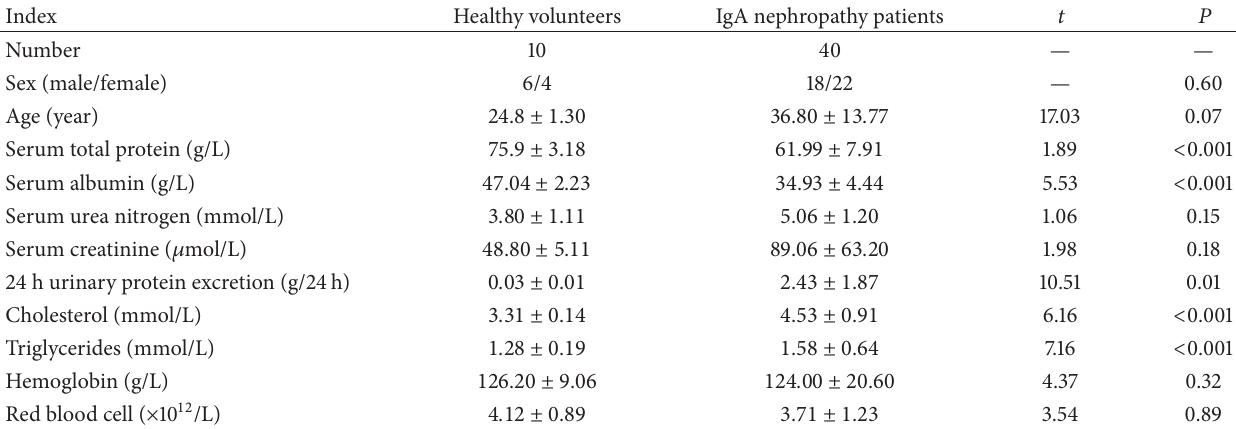
Table 1: Renal function and albumin Ang II-infusion rat and FTY720 intervention